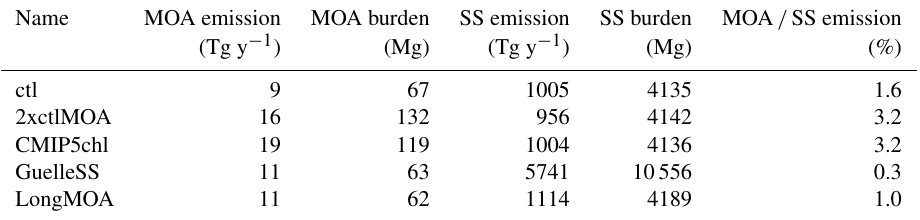
Table 4. Annual global mean MOA and SS emissions and burdens from nudged simulations. The ratio of MOA to SS emission rates (MOA / SS emission) is a global area-weighted average of the ratio calculated at individual grid boxes. Note that MOA is only emitted in the accumulation mode, while SS is emitted in both accumulation and coarse modes. In the “2xctlMOA” and “CMIP5chl” simulations, slightly different MOA emission properties are considered as explained in Table 2; for “GuelleSS”, a different SS emission is used; and lastly for “LongMOA”, changes are present in both the MOA and SS emissions when compared to the “ctl”